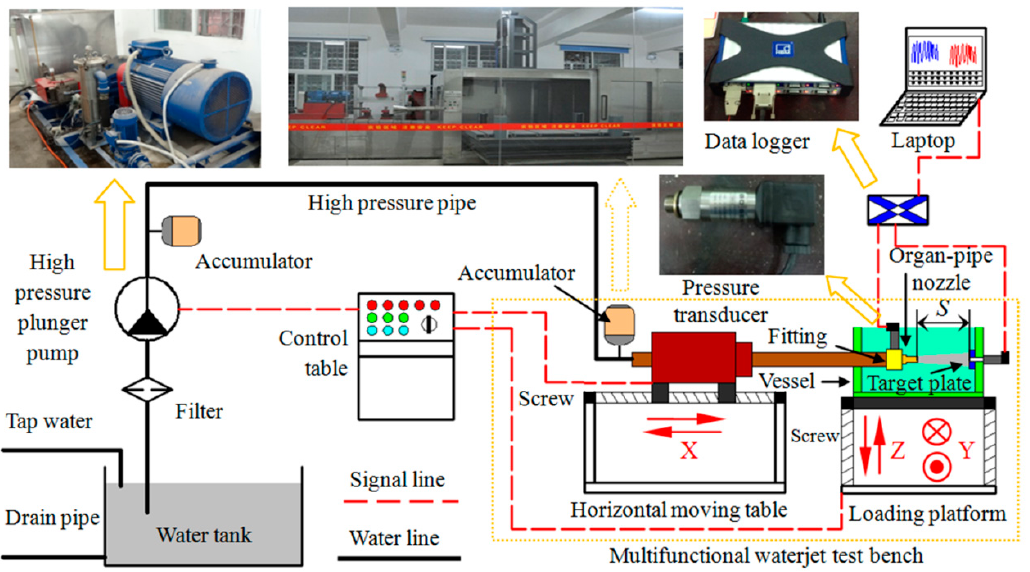
Figure 2. The schematic of the experimental setup for measuring the axial pressures [28,33–35].